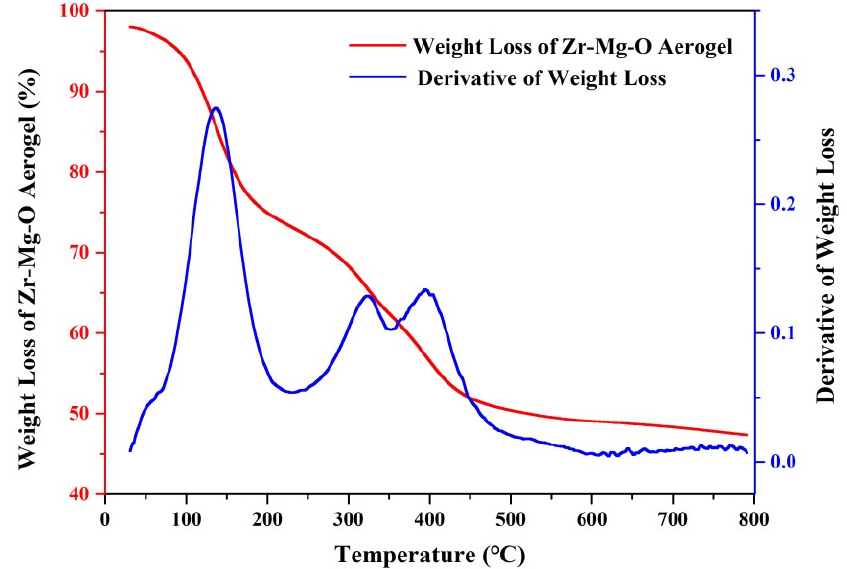
Figure 5. The TG analysis curve of the Zr–Mg mixed oxide aerogels with Zr/Mg molar ratio of 7/3. The bonding configurations of Zr (3d) (Figure 6a), O (1s) (Figure 6b), and Mg (1s) (Figure 6c) atoms in the pristine ZrO 2 aerogel and Zr–Mg mixed oxide aerogels with Zr/Mg molar ratio of 7/3 were examined using X-ray photoelectron spectroscopy (XPS), as shown in Figure 6. Zr 3d curves (Figure 6a) are fitted to two peaks corresponding to 3d 5/2 and 3d 3/2 lines, respectively. Zr 3d 5/2 and Zr 3d 3/2 peaks are located at 182.1 eV and 184.5 eV for the pristine ZrO 2 aerogel, as shown in Figure 6(i) of Figure 6a. The distance between two satellites of Zr 3d 5/2 and Zr 3d 3/2 for the pristine ZrO 2 aerogel is 2.4 eV, which is in good agreement with the reference ZrO 2 satellite peaks of Zr 3d 5/2 and Zr 3d 3/2 . This